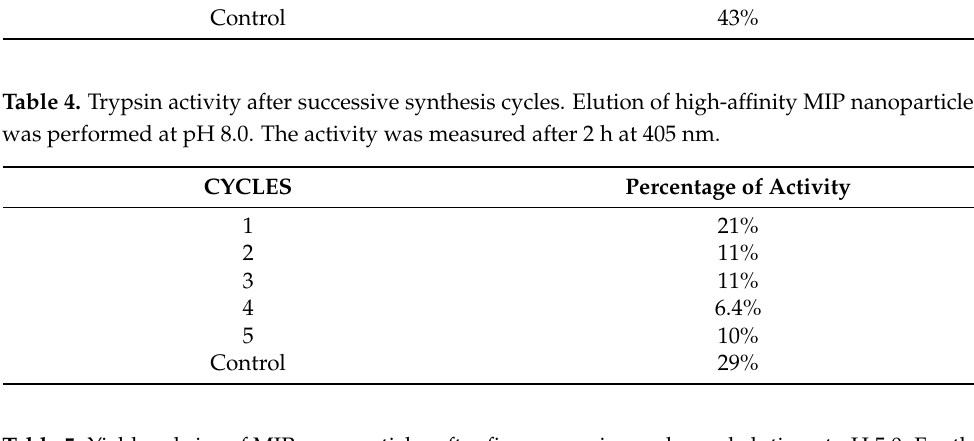
Table 5. Yield and size of MIP nanoparticles after five successive cycles and elution at pH 5.0. For the measurements of size PDIs were included.